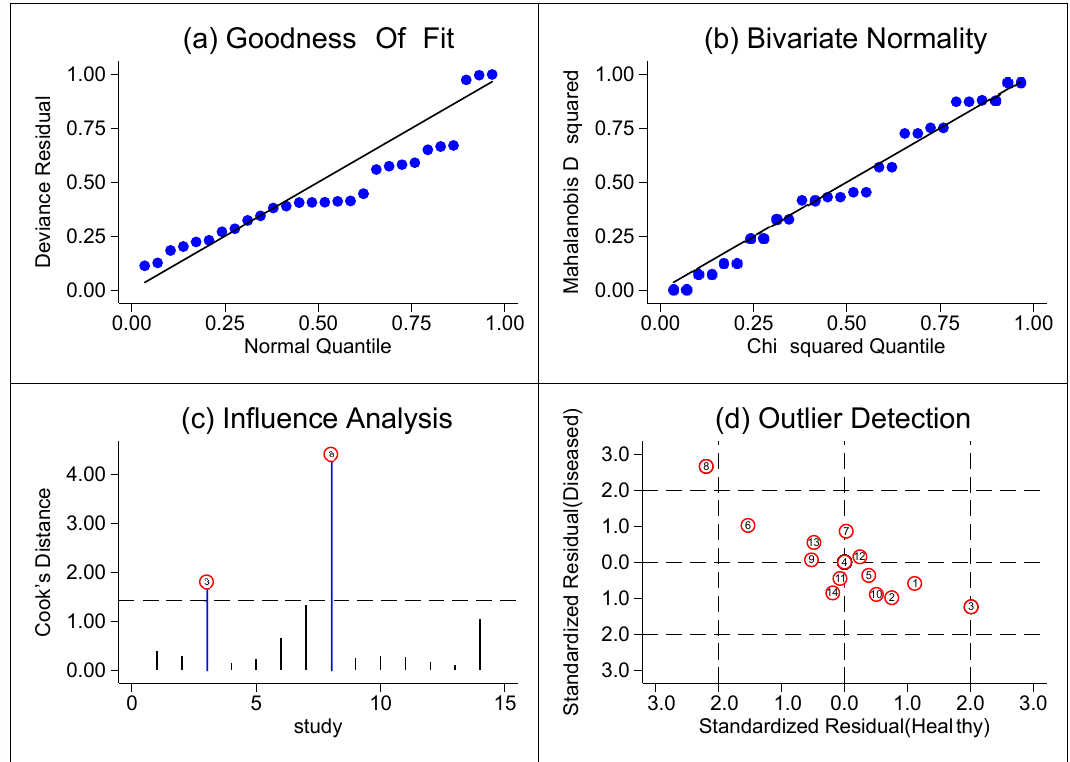
Figure 1. Graphical depiction of residual-based ( a ) goodness-of-fit, ( b ) bivariate normality, ( c ) influence and ( d ) outlier detection analyses.